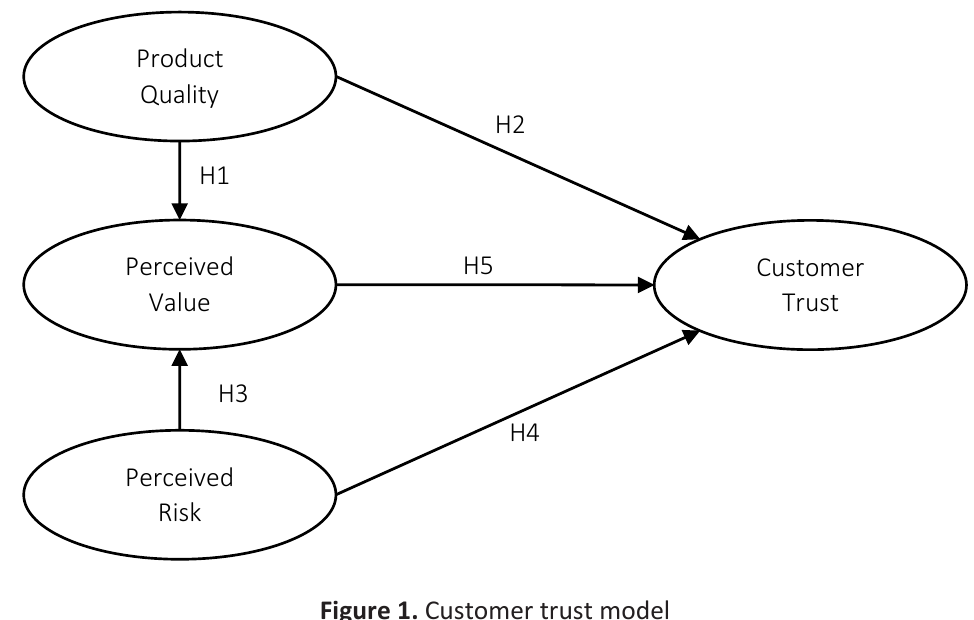
Figure 1. Customer trust